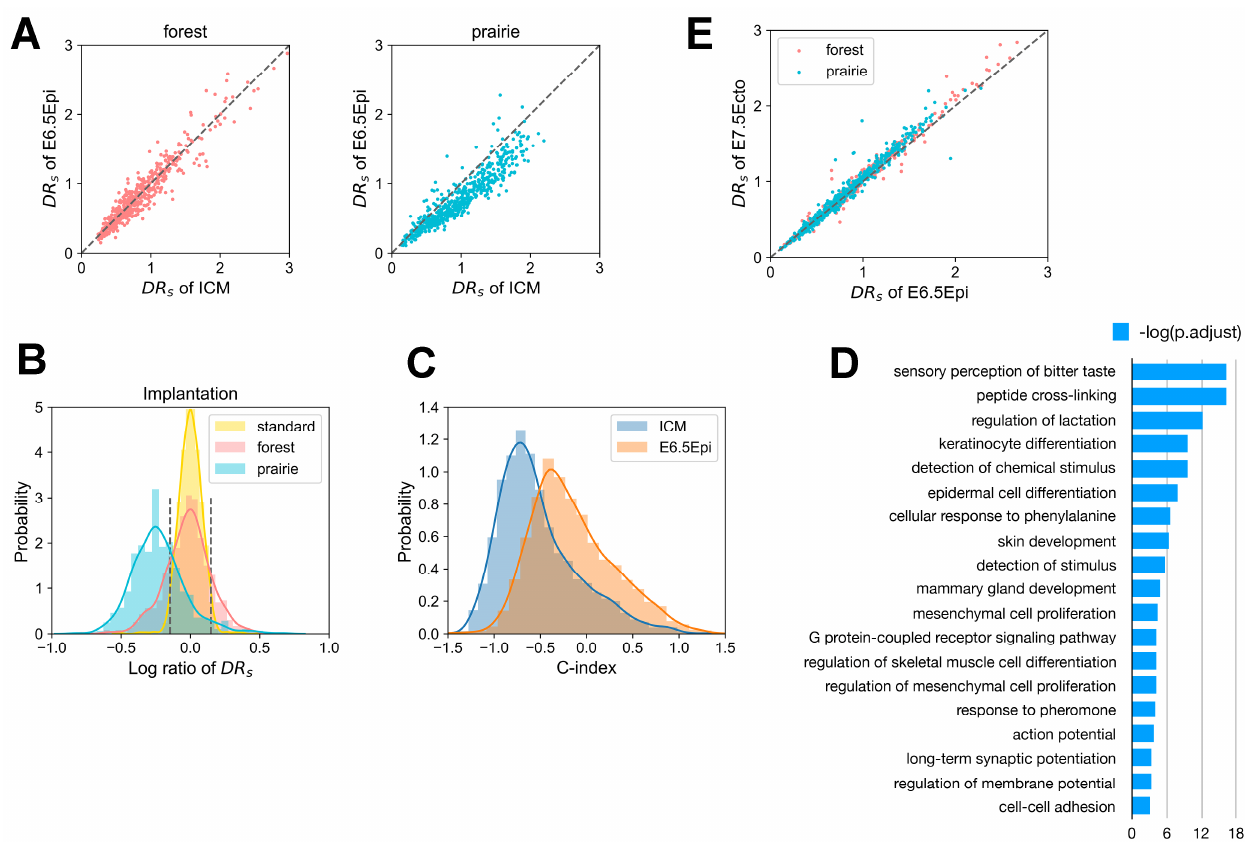
Figure 5. Implantation-related domain mixing in differentiation. ( A ) The scatter diagrams of the domain segregation ratio DR s for forests and prairies during mouse implantation. ( B ) The distribution of the logarithm ratio of DR s between mouse E6.5Epi and ICM for forests and prairies. The plot, the legend of which is “standard”, represents the logarithm ratio of DR s between two ICM replicates from the same lab. Significantly more strongly segregated domains are taken, as those whose logarithm ratio of DR s values exceed the 97.5th percentile of the “standard” distribution; accordingly, domains where the logarithm ratio of DR s is smaller than the 2.5th percentile of the “standard” distribution are regarded as significantly more mixed domains. The corresponding threshold values are 0.1469 and –0.1469, respectively, which was labeled using two black dotted lines. ( C ) The change of compartment index (C-index) for less-segregated prairies, P mix , from the mouse ICM to E6.5 epiblast stage. ( D ) Functional assignment of genes in the P mix during mouse implantation. ( E ) The scatter plot of DR s for forests and prairies between the mouse E6.5 epiblast and E7.5